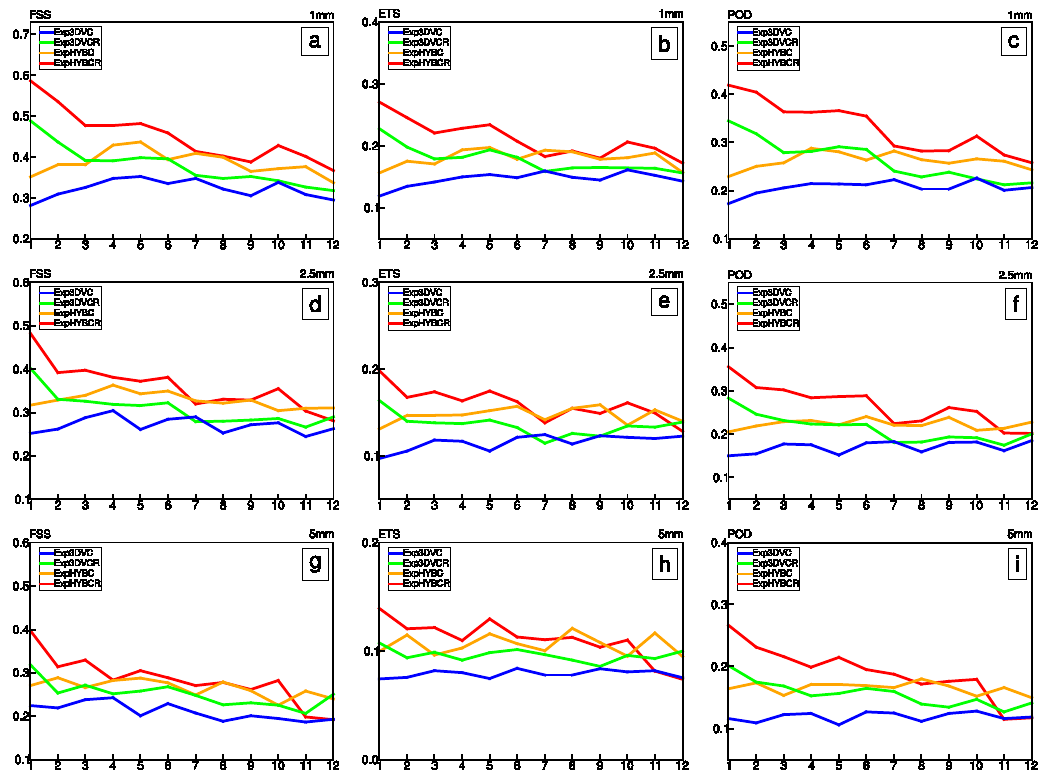
Figure 6. The fractions skill score (FSS) ( a , d , g ); the equitable threat score (ETS) ( b , e , h ); and probability of detection (POD) ( c , f , i ) of the Exp3DVC (blue curve), ExpHYBC (orange curve), Exp3DVCR (green curve) and ExpHYBCR (red curve) averaged over seven 0–12 h forecasts (initialized at 15:00, 18:00, 21:00, 00:00, 03:00, 06:00 and 09:00 UTC on 7 August 2016), for precipitation thresholds of 1, 2.5 and 5 mm.